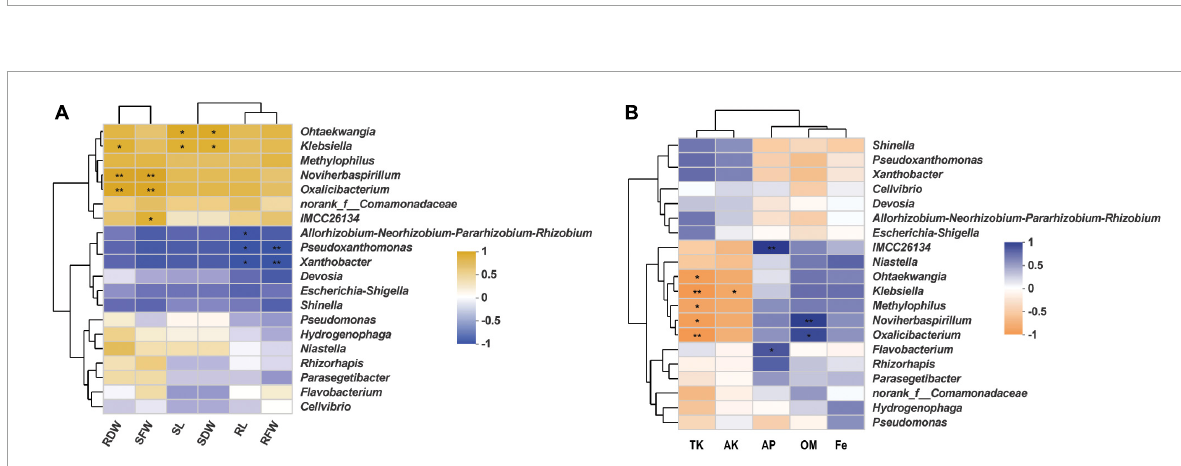
FIGURE6 The relationship of root bacterial genera and mulberry development and soil properties. (A) Heatmap of correlation between mulberry growth parameters and top 20 bacterial genera using the Spearman correlation coefficient. RDW and SDW represented the dry weight of mulberry root and shoot, respectively. RFW and SFW represented the fresh weight of mulberry root and shoot, respectively. SL and RL represented mulberry shoot length and main root length, respectively. (B) Heatmap of correlation between soil properties and top 20 bacterial genera using the Spearman correlation coefficient. TK, AK, AP, OM, and Fe represented total potassium, available potassium, available phosphorus, organic matter, and available iron,